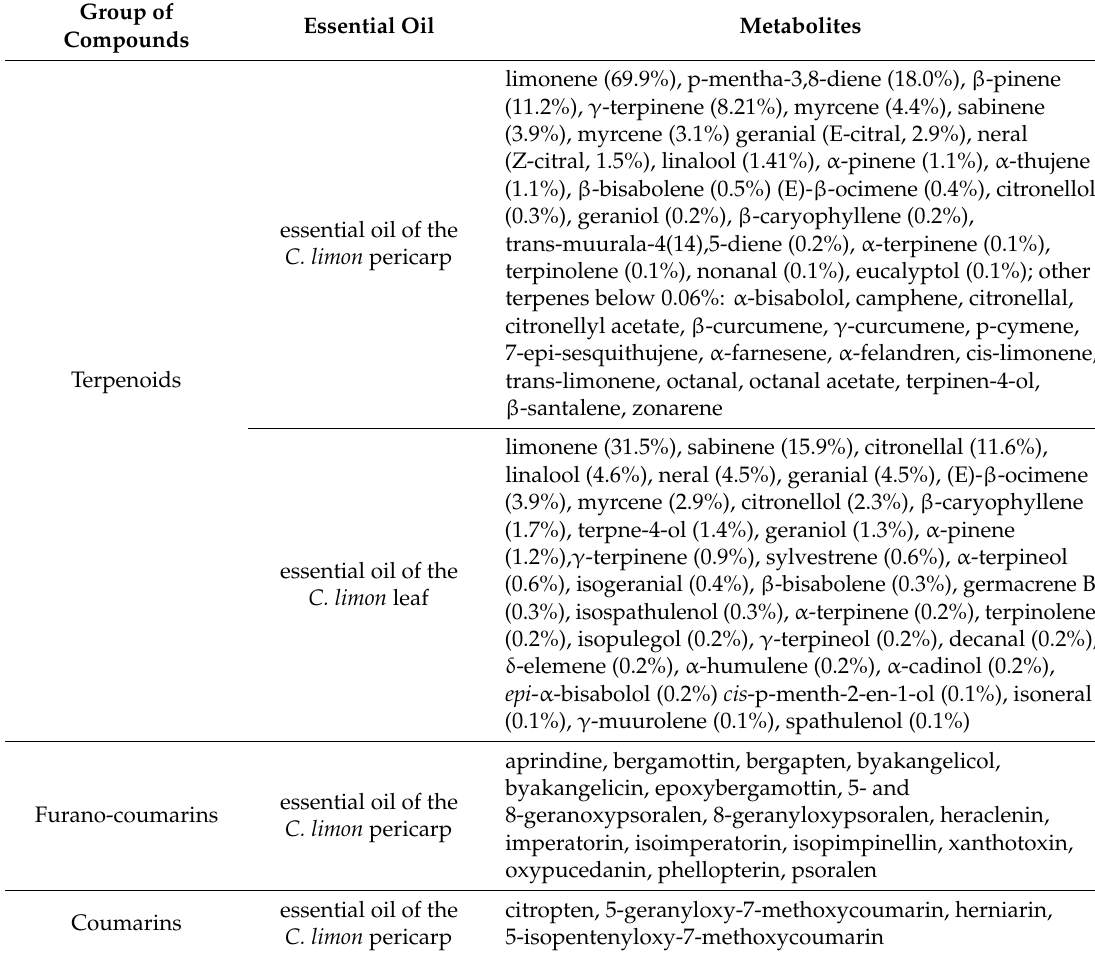
Table 6. The chemical composition of the essential oil of the C. limon pericarp and